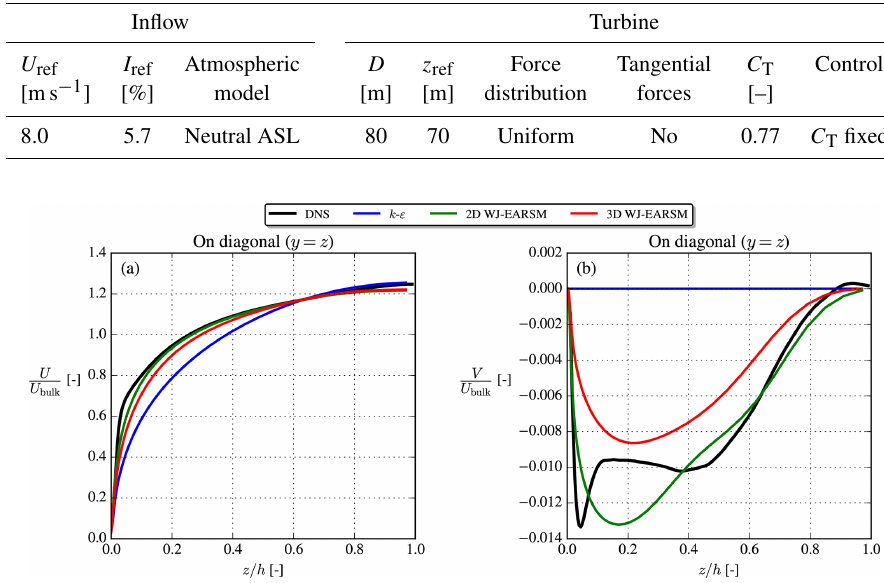
Figure 9. Streamwise velocity (a) and vertical velocity (b) on the corner bisector line. Results extracted at x/L x = 0 . 5.